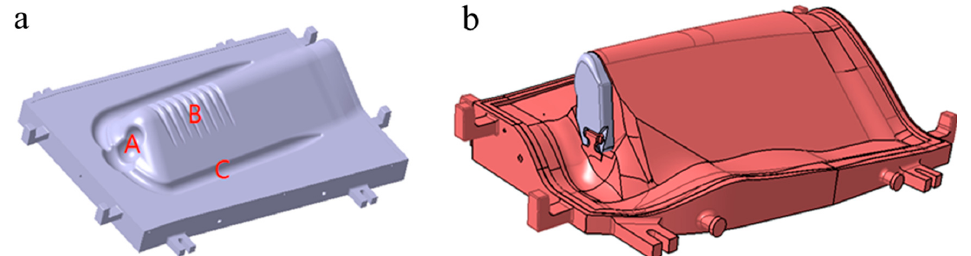
Figure 3. Male dies of ( a ) the preforming process; ( b ) final forming process.